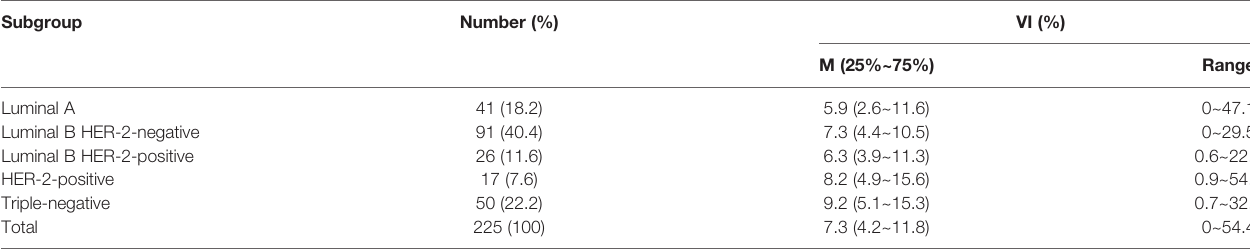
TABLE 2 | VI in different molecular subgroups of breast